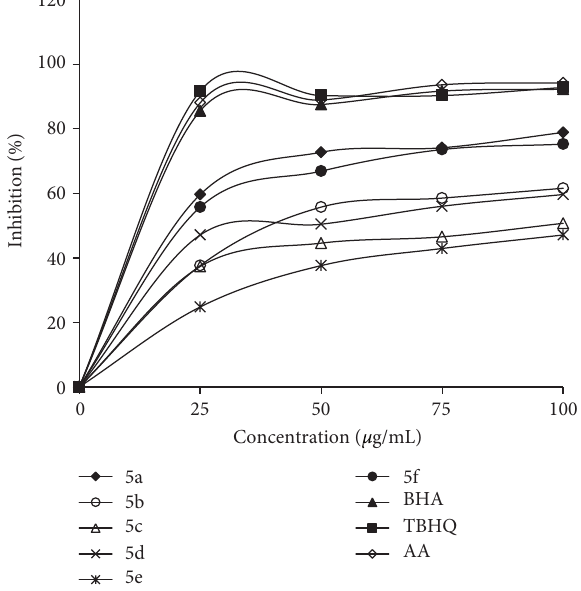
F 3: FRAP of compounds ( 3-4 ).